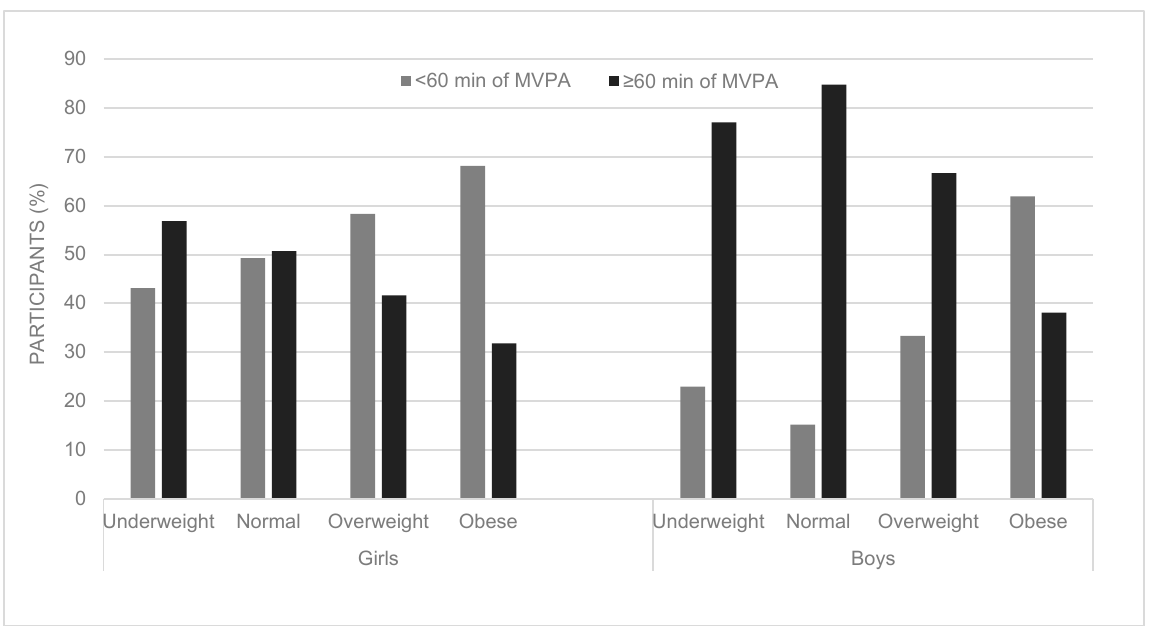
Figure 3. Percentage of children who did or did not meet ≥ 60 min MVPA, stratified by BMI categories and sex.